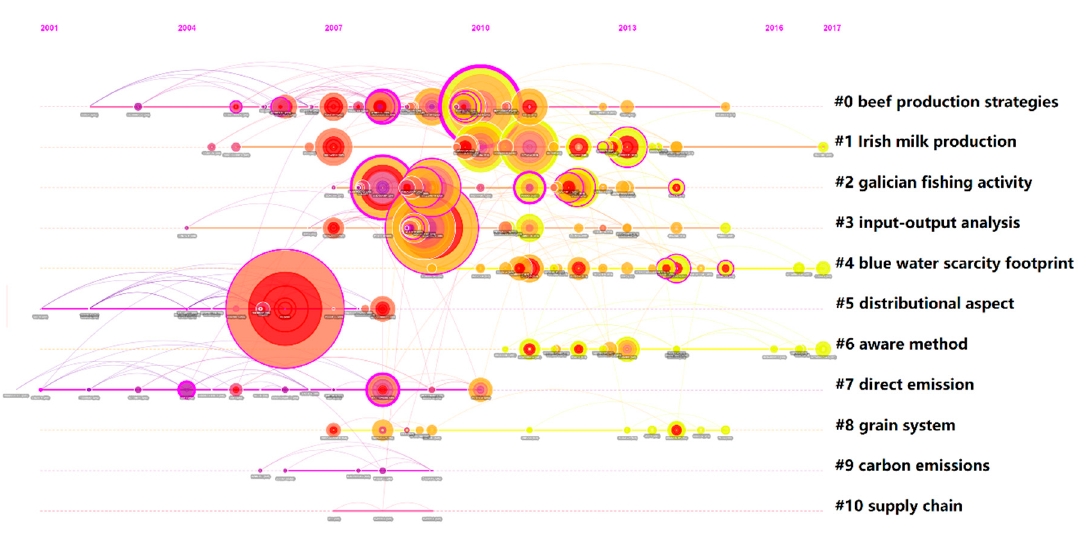
Figure 7. Timelines of co-citation clusters.